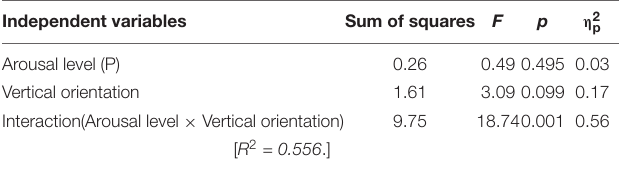
TABLE 5 | Statistics of bootstrapped factorial ANOVA: Cultural differences and arousal level for novel product. Dependent variable: Attractiveness rating for novel product P ( z